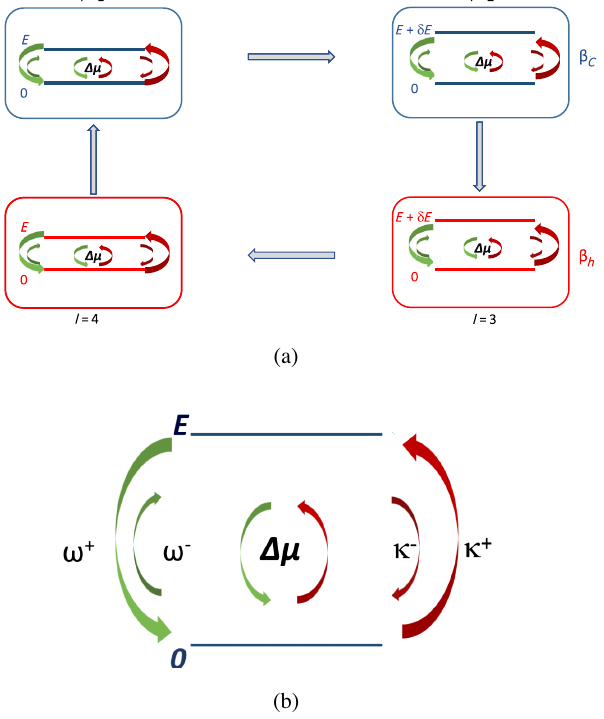
FIG. 1. (a) Depiction of the protocol for the two-state heat engine with a period divided into four parts labeled by l . The four changes are as follows: from l ¼ 1 to l ¼ 2 the energy changes from E to E þ δ E , from l ¼ 2 to l ¼ 3 the inverse temperature changes from β β l ¼ 3 to l ¼ 4 the energy changes from E þ δ E to E , c to h , from and from l ¼ 4 to l ¼ 1 the inverse temperature changes from β h to β c . (b) Possible reactions for the two-state system. The transition rate for the forward (backward) phosphorylation reaction in Eq. (3) is κ ( κ − ) and the transition rate for the forward (backward) þ dephosphorylation reaction in Eq. (4) is ω ( ω − ). We parametrize þ the transition rates as κ þ ð t Þ ¼ ω − ð t Þ ¼ k , κ − ð t Þ ¼ ke β ð t Þ½ E ð t Þþ Δ μ (cid:2) , and ω þ ð t Þ ¼ ke β ð t Þ E ð t Þ . FIG. 2. Work and efficiency for the two-state heat engine depicted in Fig. 1. (a) Work as a function of Δ μ and δ E for E ¼ 1 and β h ¼ 0 . 5 . Work for an active heat engine can be larger as compared to the work of its passive counterpart for Δ μ ¼ 0 . (b) The pseudo-efficiency η is larger than the Carnot efficiency ps η E ¼ 0 . 1 and δ E ¼ 0 . 5 . For both C in the blue filled region, for figures β c ¼ 1 , k ¼ 1 , and τ ¼ 1 . These parameters correspond to an arbitrary cold temperature. The hot temperature is the cold temperature times β − 1 h . The parmaeters E , δ E , and Δ μ are all in units of β − 1 c